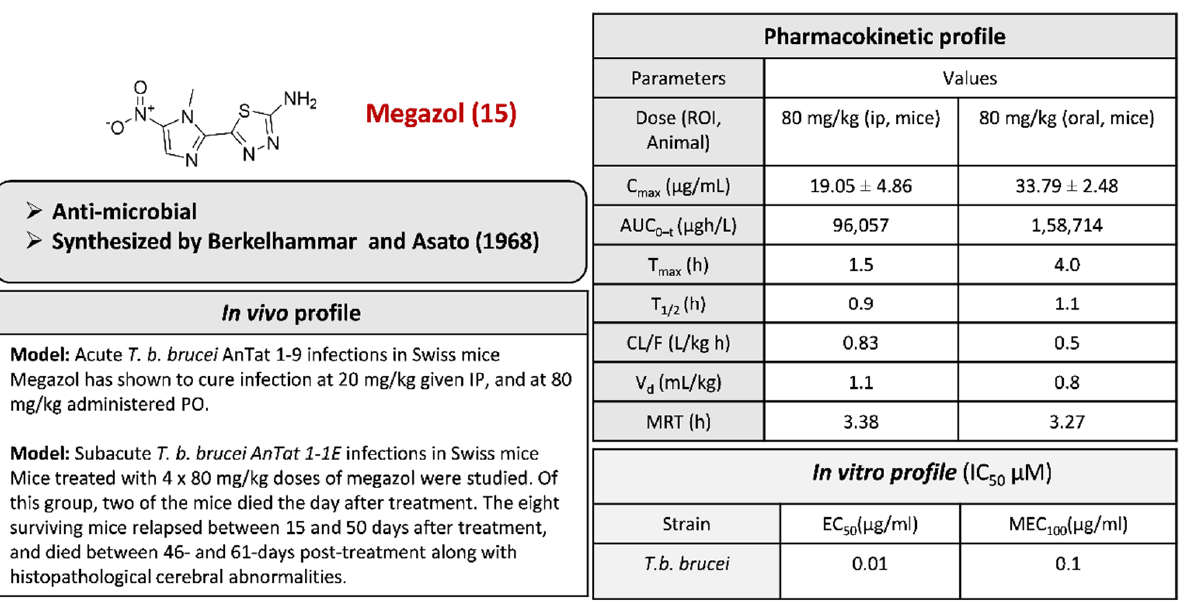
Figure 19. Activity profile of Megazol 15 [144,145]. As shown in Scheme 38, the first attempt to synthesize Megazol 15 was performed by Berkelhammer et al. in 1968 (route A) [143]. In this route, Megazol 15 was synthesized by ferric ammonium sulfate catalyzed oxidative cyclization of 1-methyl-5-nitroimidazole- 2-carboxaldehyde thiosemicarbazone in hot water. In 2003, Chauviere et al. proposed a new synthetic route for the synthesis of Megazol 15 (route B) [146]. Here, the carbanion at position 2 of 1-methylimidazole was quantitatively thiomethylated with dimethyl disulfide followed by nitration to furnish the corresponding 5-nitroimidazole. Then, oxidation by hydrogen peroxide led to the sulfone where a nucleophilic substitution by cyanide anion produced the corresponding carbonitrile. Finally, a condensation with thiosemicarbazide in trifluoroacetic acid followed by cyclization and isomerization produced Megazol 15 . In 2008, Foroumadi et al. synthesized Megazol 15 from 1-methyl-5-nitro-1H-imidazole-2- carbaldehyde (route C) [147], wherein 1-methyl-5-nitro-1 H -imidazole-2-carbaldehyde was refluxed with thiosemicarbazide in ethanol, producing 2-((1-methyl-5-nitro-1H-imidazol-2- yl)methylene)hydrazine-1-carbothioamide, which upon further reaction with ferric ammo- nium sulfate, furnished Megazol 15